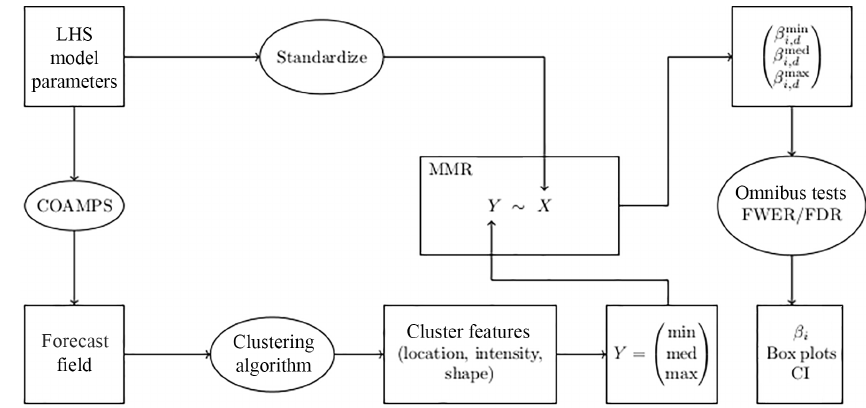
Figure 1. The flowchart highlighting the main components of the methodology.